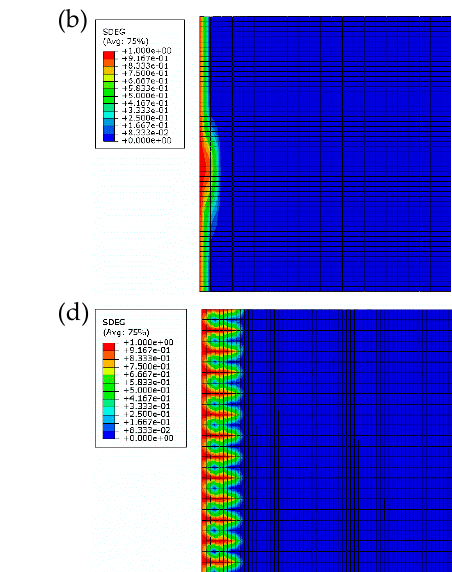
Figure 15. Damage contours at the delamination fronts (half width): ( a ) benchmark case for the Mode I model; ( b ) Mode I model with element size 0.5 mm along the length; ( c ) benchmark case for Mode II model; ( d ) Mode II model with element size 0.5 mm along the width.